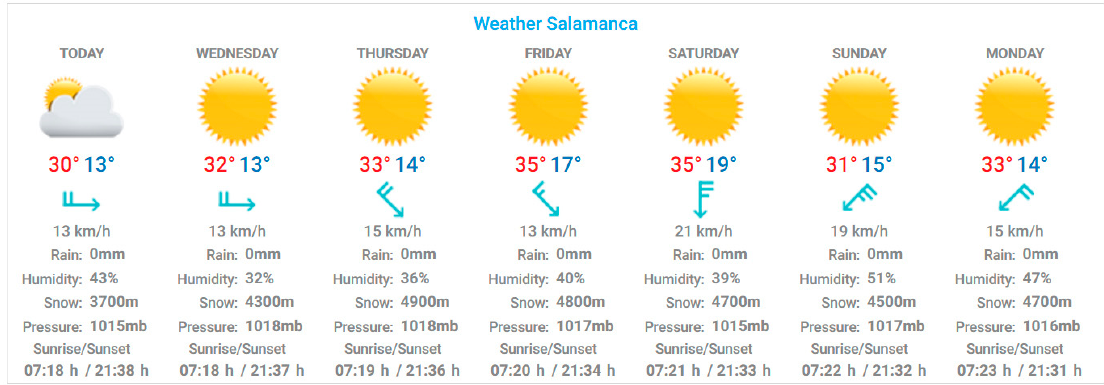
Figure 19. Smart TV application that shows the weather forecast.